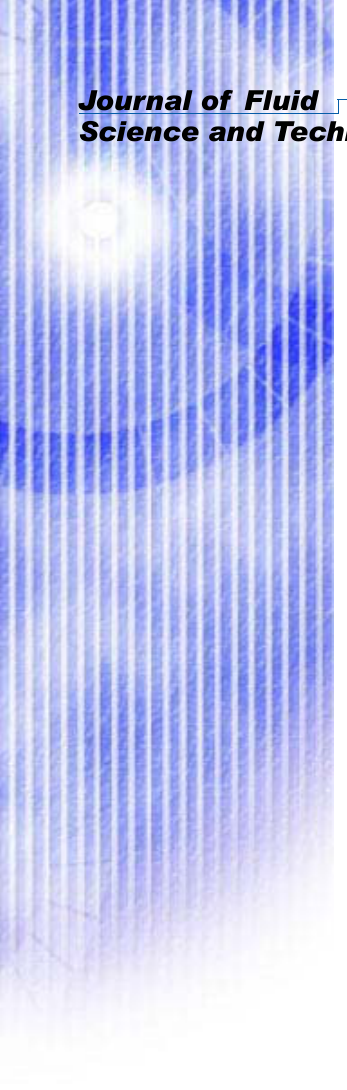
= 0.1 MPa, σ = 0.003, t 2